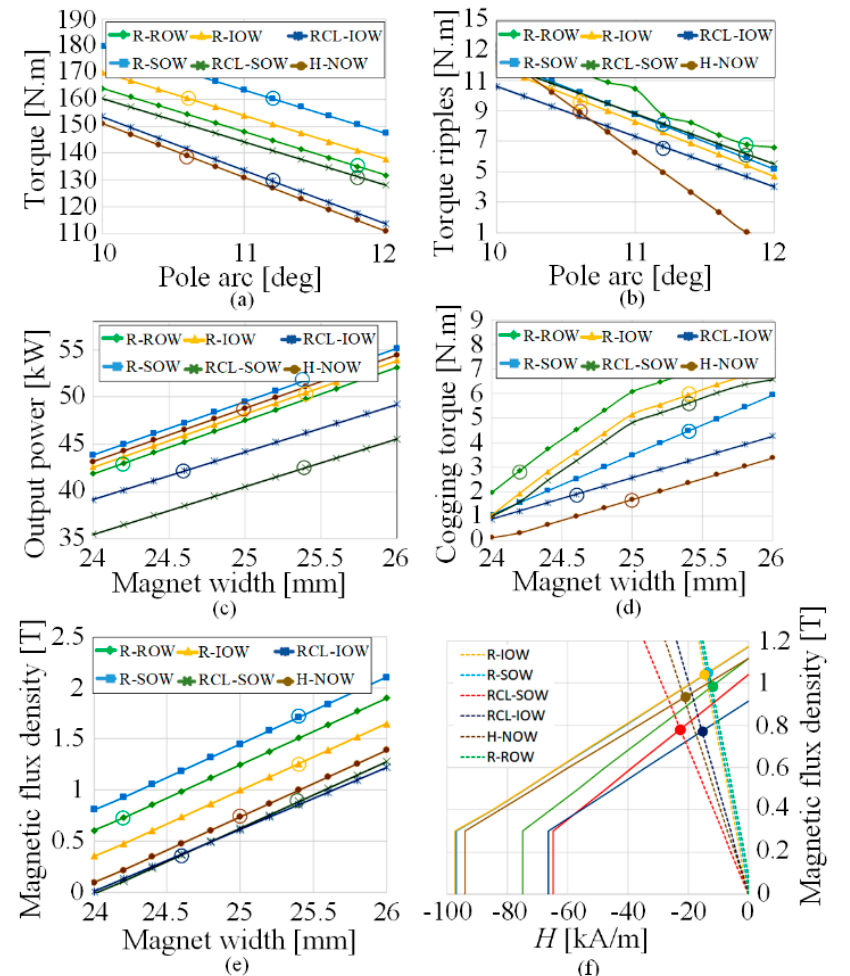
Figure 3. Sensitivity analysis for magnet sizing, in terms of: ( a ) electromagnetic torque as a function of pole arc, ( b ) electromagnetic toque ripples level as a function of pole arc, ( c ) output power as a function of magnet width, ( d ) cogging torque as a function of magnet width, ( e ) magnetic flux density as a function of magnet width, and ( f ) demagnetization curves for the considered PM arrangements. The circles highlight the selected parameter values for each configuration.